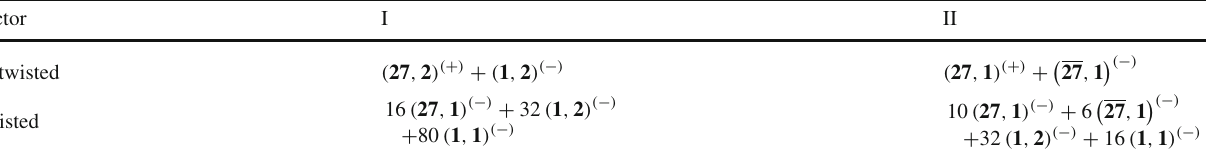
an extra Z 2 symmetry is imposed forbidding a mixing between Z 2 -even (“visible”) and Z 2 -odd (“hidden”) sectors. We assume that { ... } ( + ) remain at low energies and contain the SM sectors, while all { ... } ( − ) acquire large masses and are integrated out below E 8 energy scale